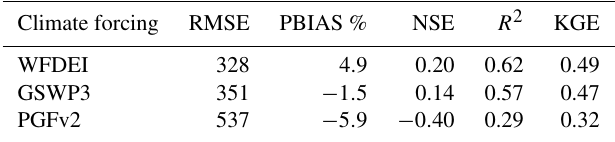
Table A3. The mean performance of climate forcing datasets, averaged over all 10 monitoring stations and all GHMs.